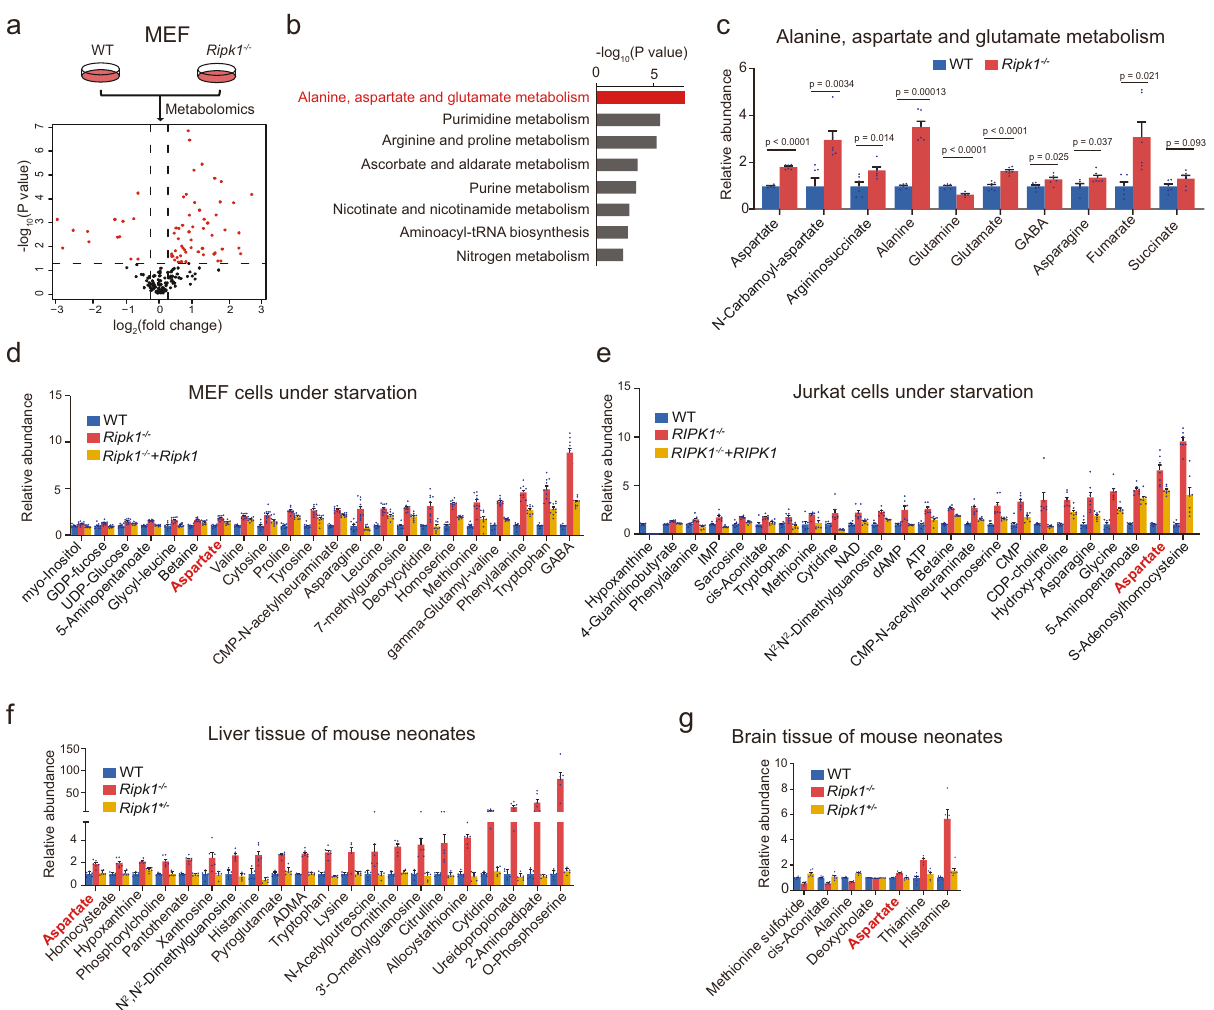
Fig. 2 Aspartate is a RIPK1-dependent metabolite under starvation. a Volcano plot of metabolites in WT and Ripk1 − / − MEFs under normal culture conditions. P values were determined by a two-tailed Student ’ s t -test. Red dots indicate signi fi cantly changed metabolites ( p < 0.05 and fold change >1.2, n = 6 biologically independent samples in each group). b Pathway enrichment analysis of signi fi cantly changed metabolites in MEFs in ( a ). c Relative abundances of metabolites in the alanine, aspartate, and glutamate metabolism pathway were measured in MEFs. n = 6 biologically independent samples in each group. P values were determined by a two-tailed Student ’ s t -test. d , e Metabolites were signi fi cantly increased/decreased in Ripk1 − / − group compared with WT group ( p < 0.05), and signi fi cantly rescued ( p < 0.05) in Ripk1 − / − + Ripk1 group compared with Ripk1 − / − group: MEFs ( d , WT group, n